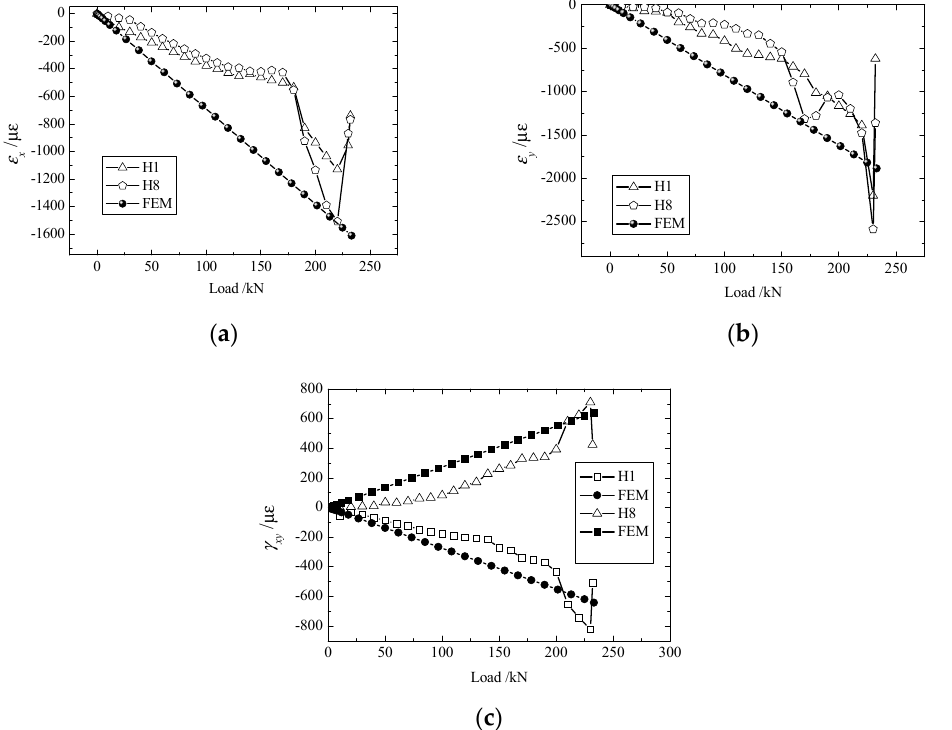
ε ε ; ( b ) , and ( c ) xy y